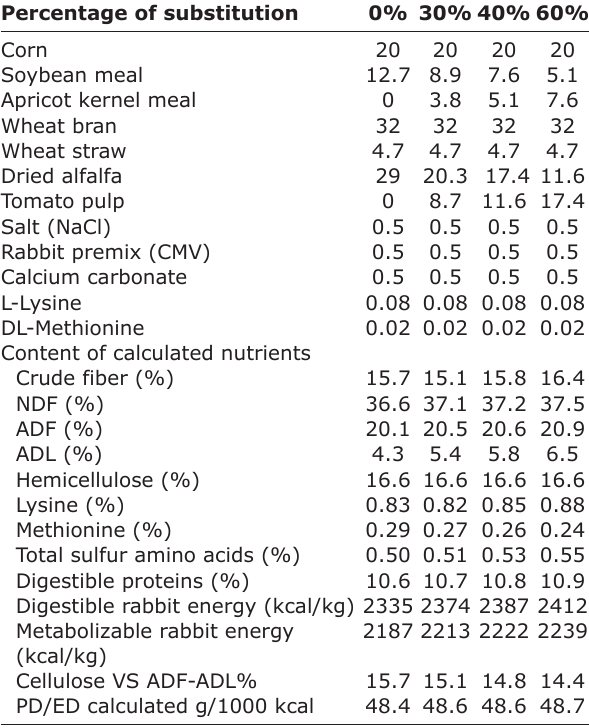
Table-2: Formula (kg/100 kg of feed) of feed distributed based on the substitution rate of soybean meal by DAKM and alfalfa by